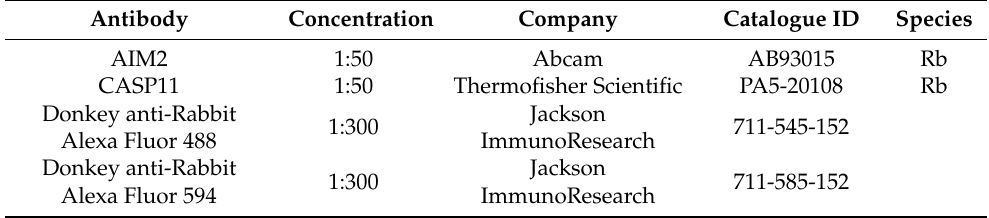
Table 1. List of primary and secondary antibodies utilised for immunofluorescence. Antibody